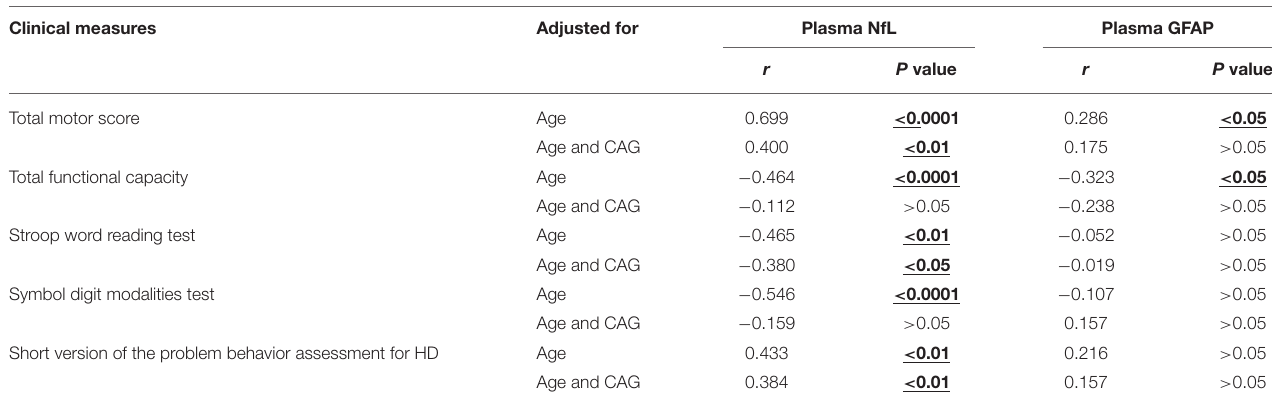
TABLE 2 | Association between plasma NfL/GFAP and clinical measures in HD mutation carriers. Clinical measures Adjusted